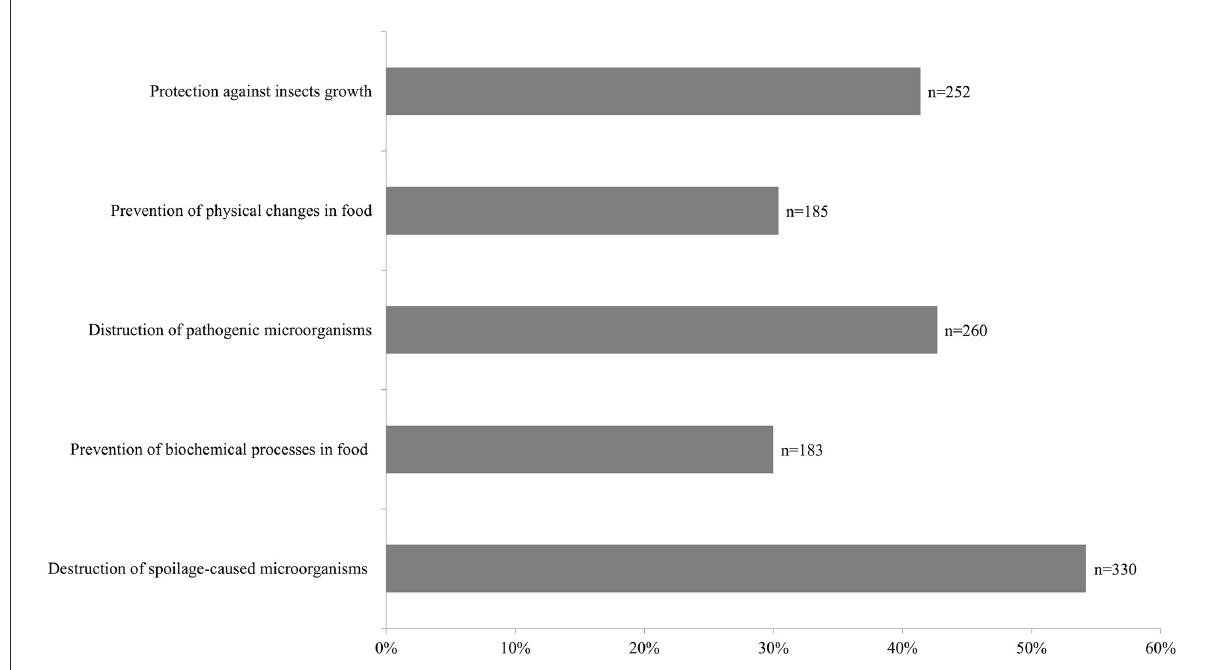
FIGURE1 Factors that influence the choice of food preserved by the respondents ( multiple choice question ).